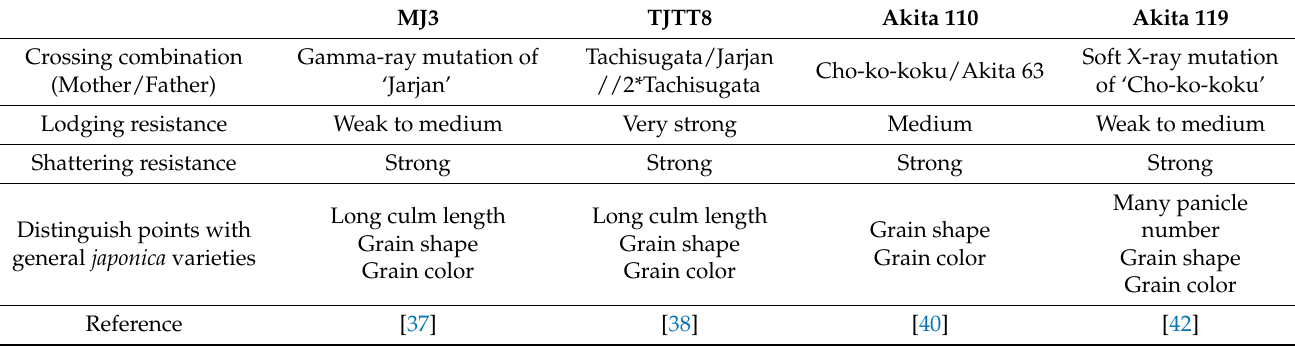
Table 1. Characterization of ‘MJ3’, ‘TJTT8’, ‘Akita 110’, and ‘Akita 119’. “2*Tachisugata” means crossing twice with